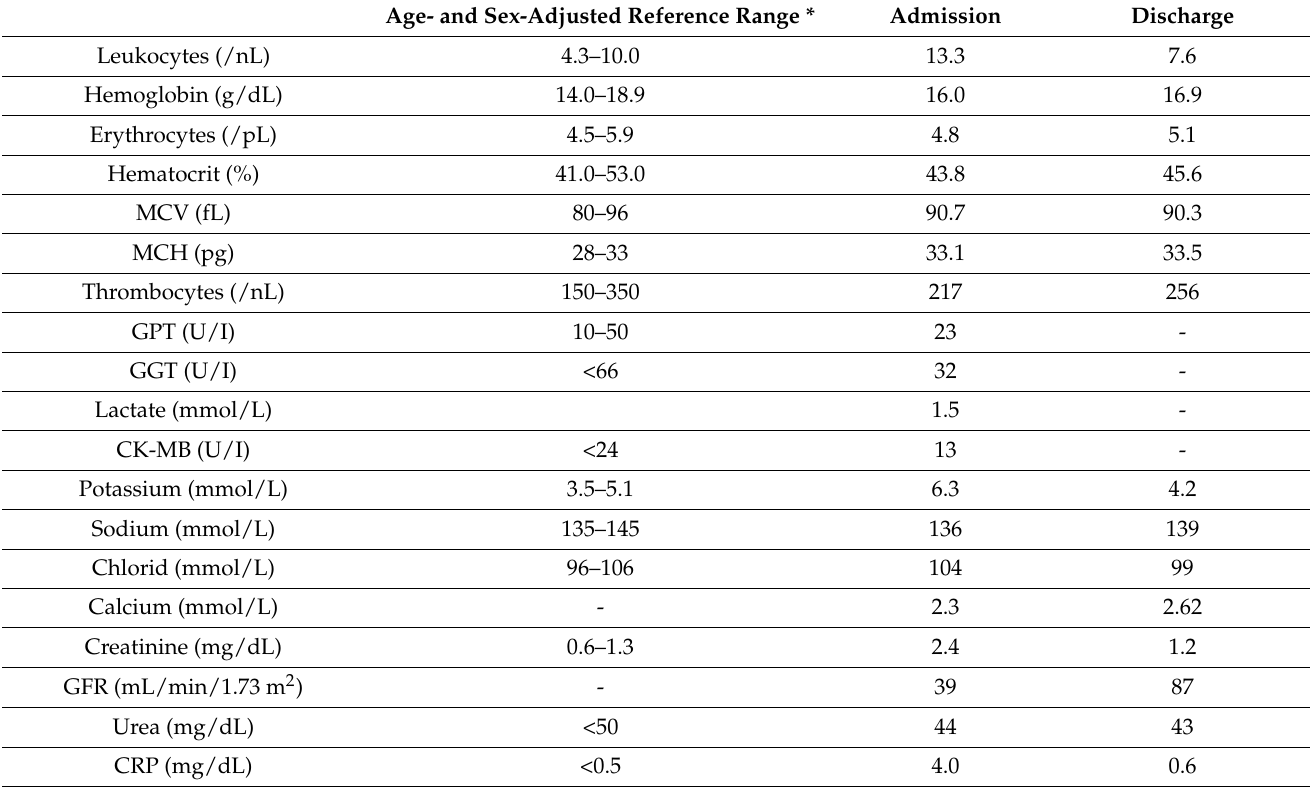
Table 1. Laboratory findings from Case I ◦ .